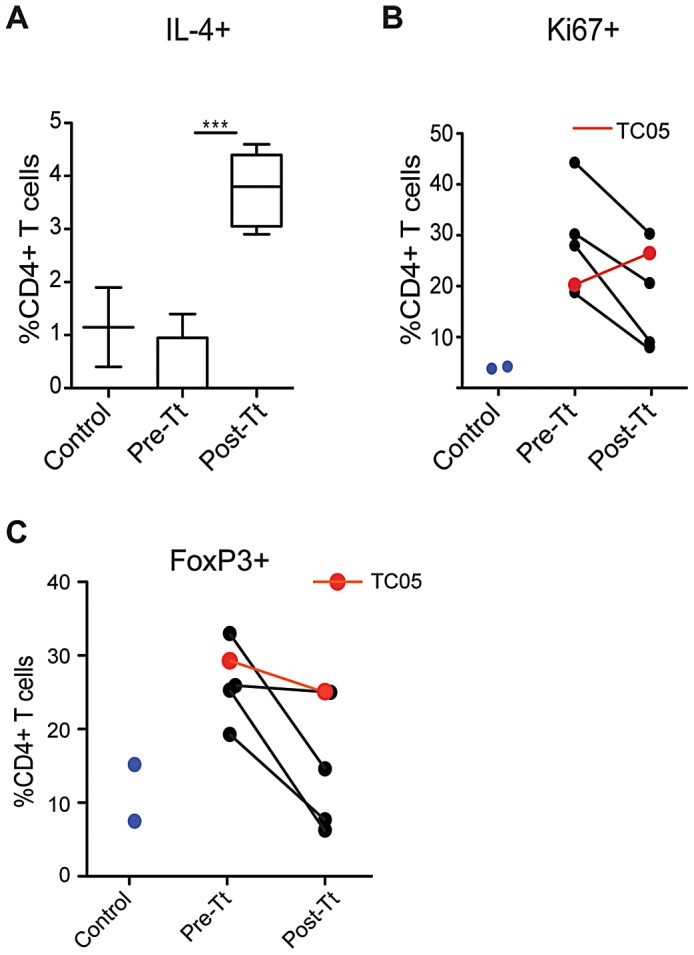
Flow cytometric analysis of CD4+ T cells from colon biopsies following T. trichiura treatment.Pinch biopsies collected during colonoscopies pre-treatment (Pre-Tt) and 14 weeks post-treatment (Post-Tt) were compared with samples collected from healthy age-matched controls (Control). Lamina propria mononuclear cells (LPMCs) from biopsies were stimulated ex vivo with PMA and ionomycin for intracellular cytokine staining. (A) Box and whisker plot showing the percentage of IL-4+ cells among CD4+ LPMCs. ***p<0.001, determined by Student's t-test. LPMCs were also stained ex vivo for intranuclear (B) Ki67 and (C) FoxP3. Lines connect paired samples from the same subjects pre- and post-treatment. The non-responding macaque (TC05) is shown in red.